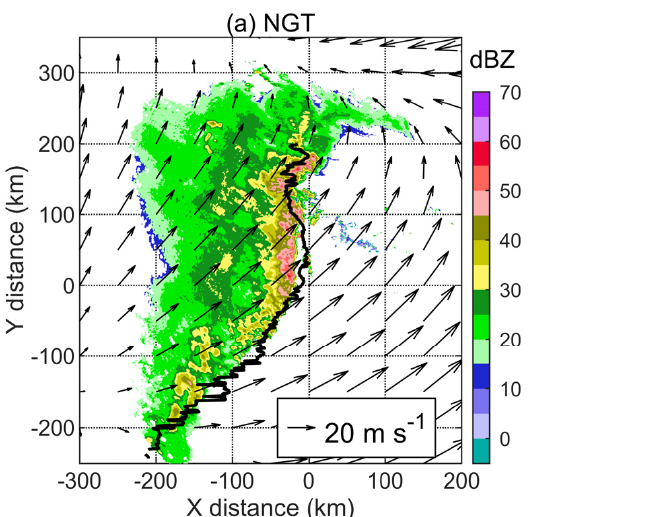
Figure 5. Sixty-minute prediction results. The target time is 10:05 UTC on 20 May 2011. The shading is the predicted CAPPI at a height of 3 km. The black solid lines are the 30 dBZ leading edge of the convective echo observed at the target time (Figure 3c). The vector fields are obtained by NGT and OF for backward interpolation. ( a ) NGT; ( b ) OF.